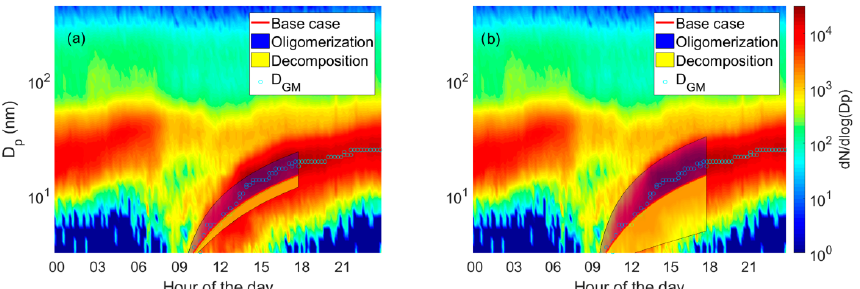
Figure 8. Observed particle size distribution, geometric mean diameters of nucleation mode ( D GM ) and the model results on diameter of the particle as a function of time in simulations based on measured gas-phase concentrations. The base case simulation with no reactions is shown with the red line. The blue area shows the possible contribution of oligomerization to the growth, i.e., the envelope of the simulations in which oligomerization was allowed. The yellow area shows the possible contribution of decomposition to the growth, i.e., the envelope of the simulations in which decomposition was allowed. The measured particle size distribution is shown in the background. (a) Model simulations in which one-third of the VBS bin was allowed to react. (b) Model simulations in which the whole VBS bin was allowed to